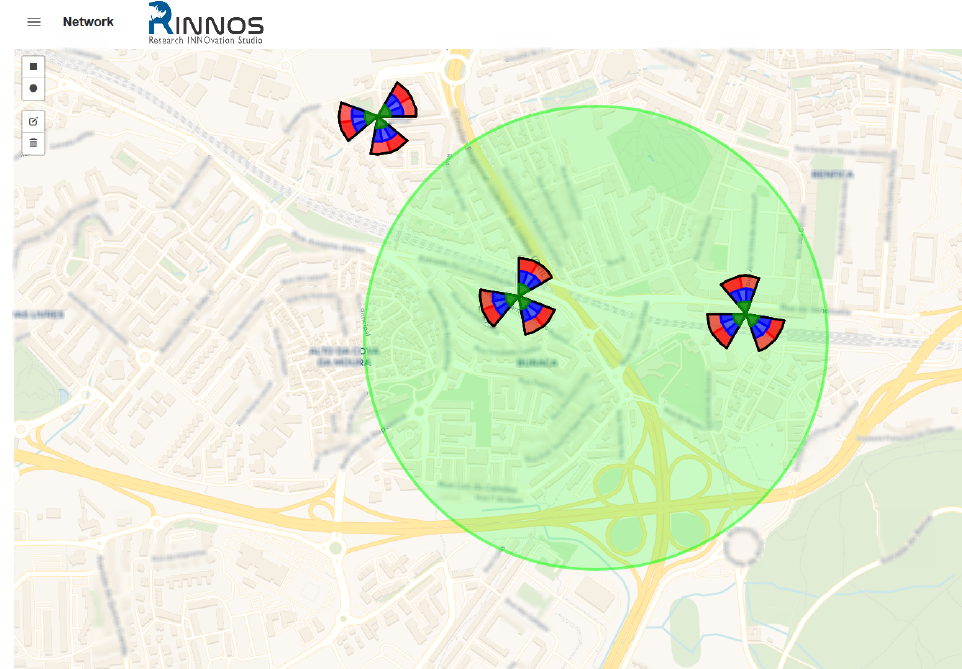
Figure 10. The failure location (green circle) and network context (2G/3G/4G